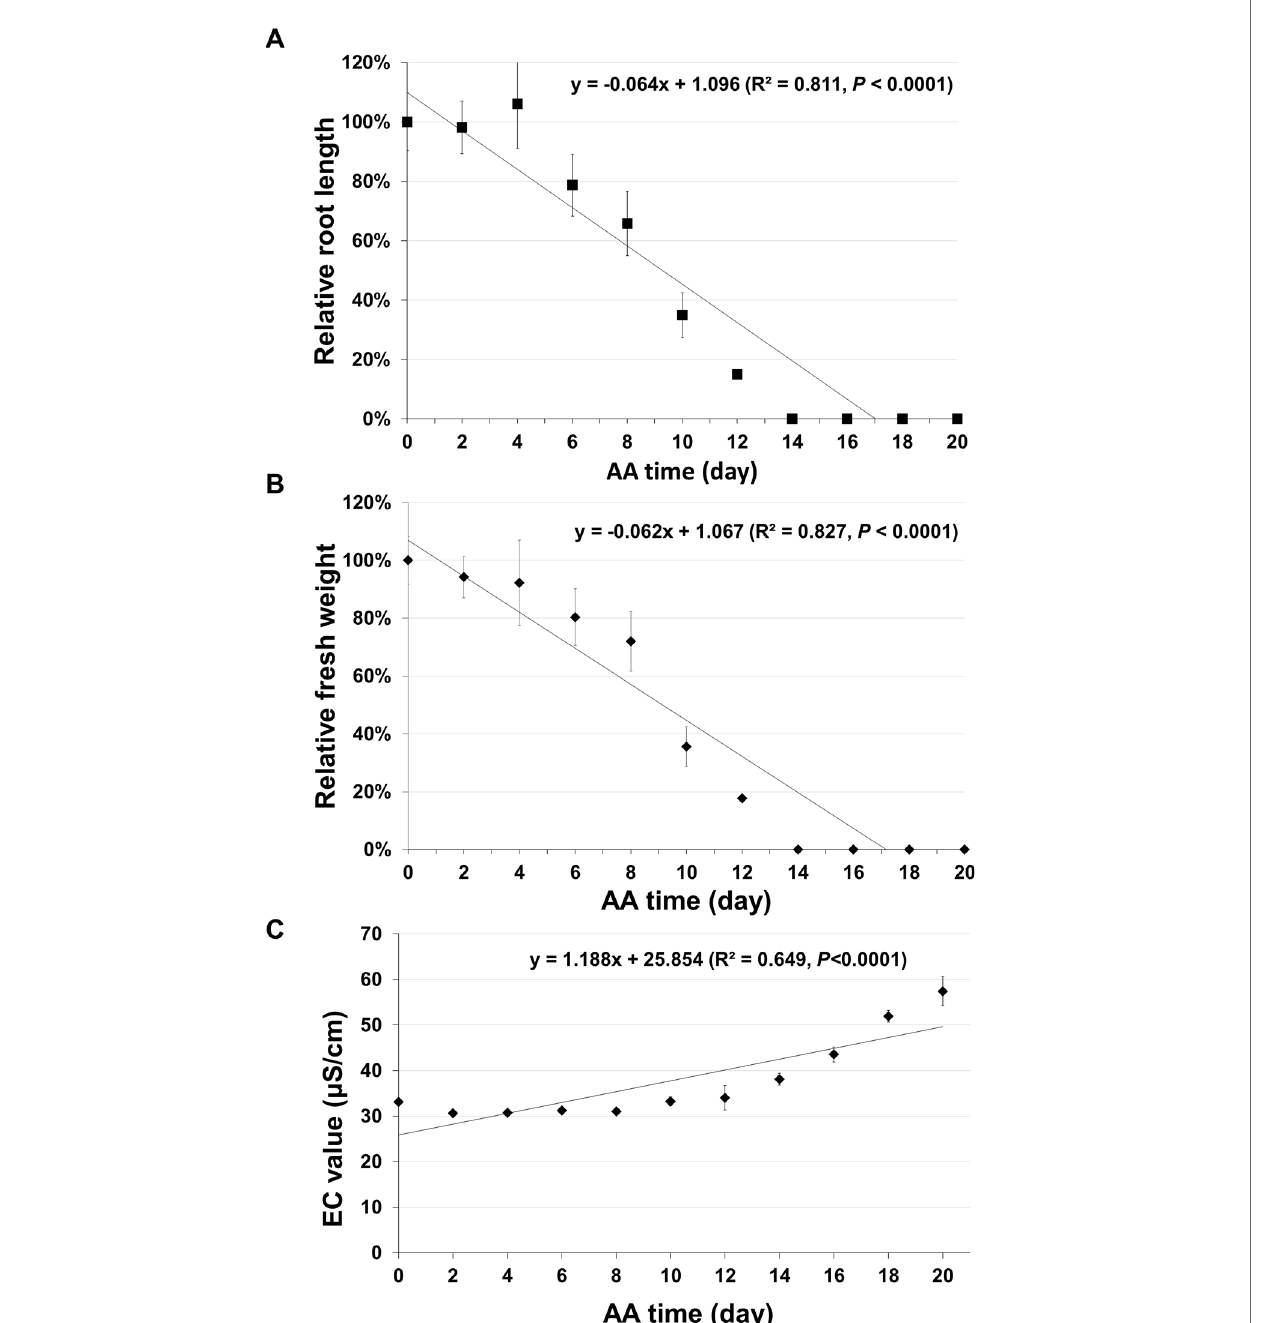
FIGURE 7 | Analysis of seed aging by traditional methods. Arti fi cially aged (AA) seeds were analyzed based on seedling growth and electrical conductivity (EC) test. Two parameters of seedling growth were determined. For each time point, fi ve plates were used and each plate had unaged and aged seeds planted side-by-side. After 10 days of incubation, the relative primary root length and fresh seedling weight (the ratio between aged and control samples) were obtained for each plate. Each datum is based on fi ve plates with the standard error shown. (A) Relative primary root length. (B) Relative seedling fresh weight. (C) EC value. Seeds (10 mg) of different aging times (with three biological repeats for each time point) were soaked in 1.5 ml ddH2O used and EC analysis was performed after 16 hours of incubation. Linear regressions were obtained with Microsoft Excel 2010 and had a P <